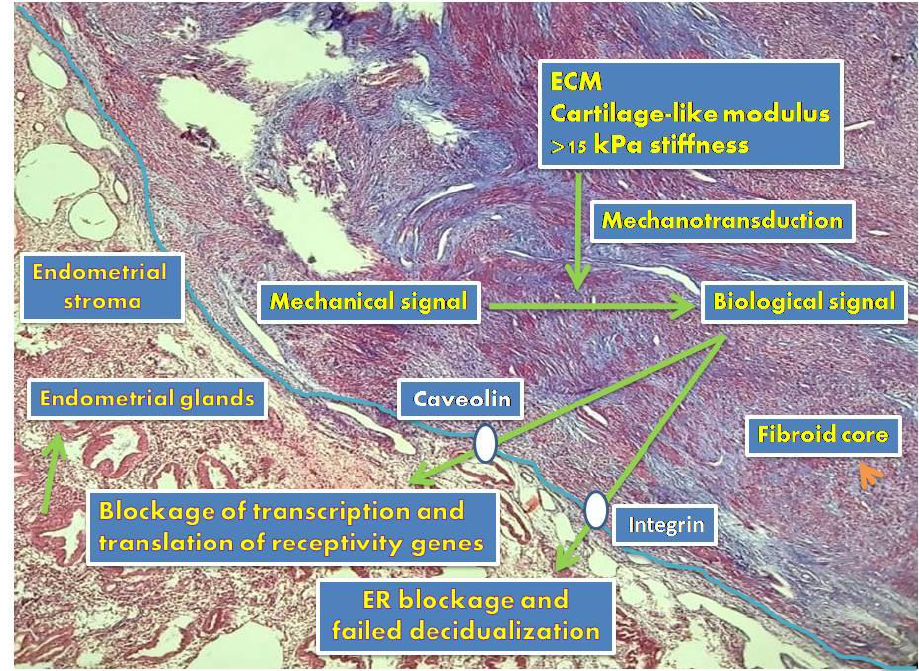
Figure 2. Representative image of Masson trichrome-stained fibroid-endometrium border (blue-green colors show collagen and red shows muscle cells) examined under light microscopy (20 × ). Fibroid-derived mechanical signals that reach the endometrium by transforming into a biological signal can block the expression of receptivity genes both transcriptionally and translationally. Failed expression of receptivity genes may prevent ovarian sex steroids from acting adequately in the endometrium, leading to insufficient decidualization and implantation defect.